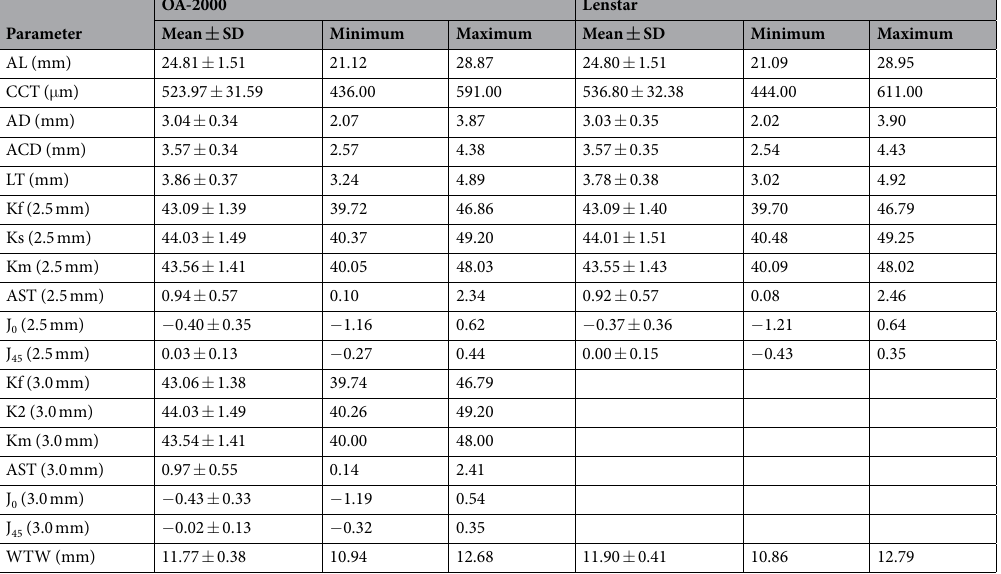
Table 1. The biometric measurement parameters provided by the OA-2000 swept-source optical coherence tomography and Lenstar optical low coherence reflectometry. AL = Axial length, CCT = central corneal thickness, AD = aqueous depth, ACD = anterior chamber depth, LT = Lens thickness, Kf = flattest keratometry,